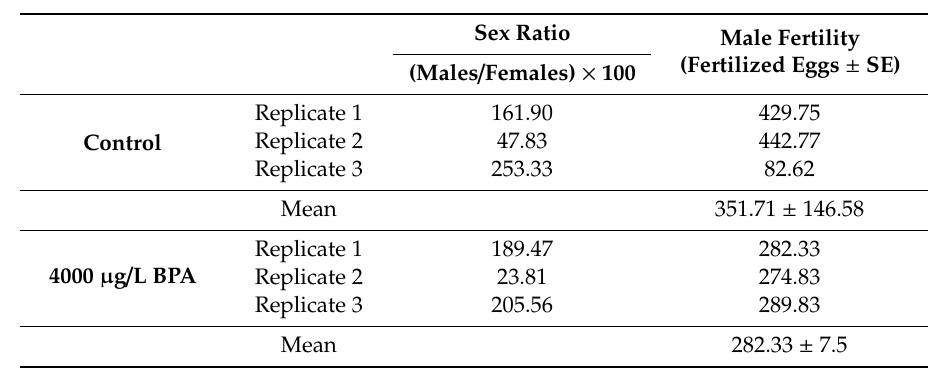
Table 1. Sex ratio and male breeding capacity. Female / male rates in three replicates of control and treated fish are shown in left column ( p = 0.868; power = 5.2%), whereas male fertility indicated as mean of fertilized eggs at 3 hpf in four di ff erent spawns per replicate are represented in the right column ( p = 0.775; power =